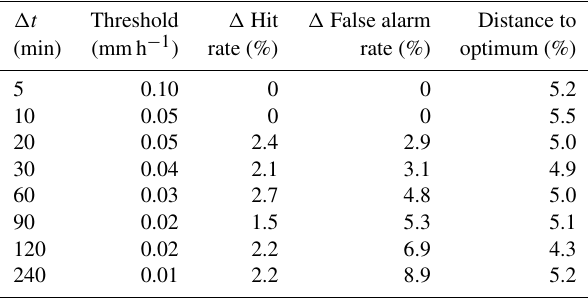
Table 2. Minimum precipitation thresholds established in the cali- bration period to optimize precipitation detection for different inte- gration times. The thresholds are chosen to minimize the distance to an ideal point in a receiver operating characteristic (ROC) diagram (i.e., a hit rate equal to 1 and a false alarm rate equal to 0, Fig. 4). The corresponding reduction in hit and false alarm rates and the re- sulting distance to this point are given for the independent validation